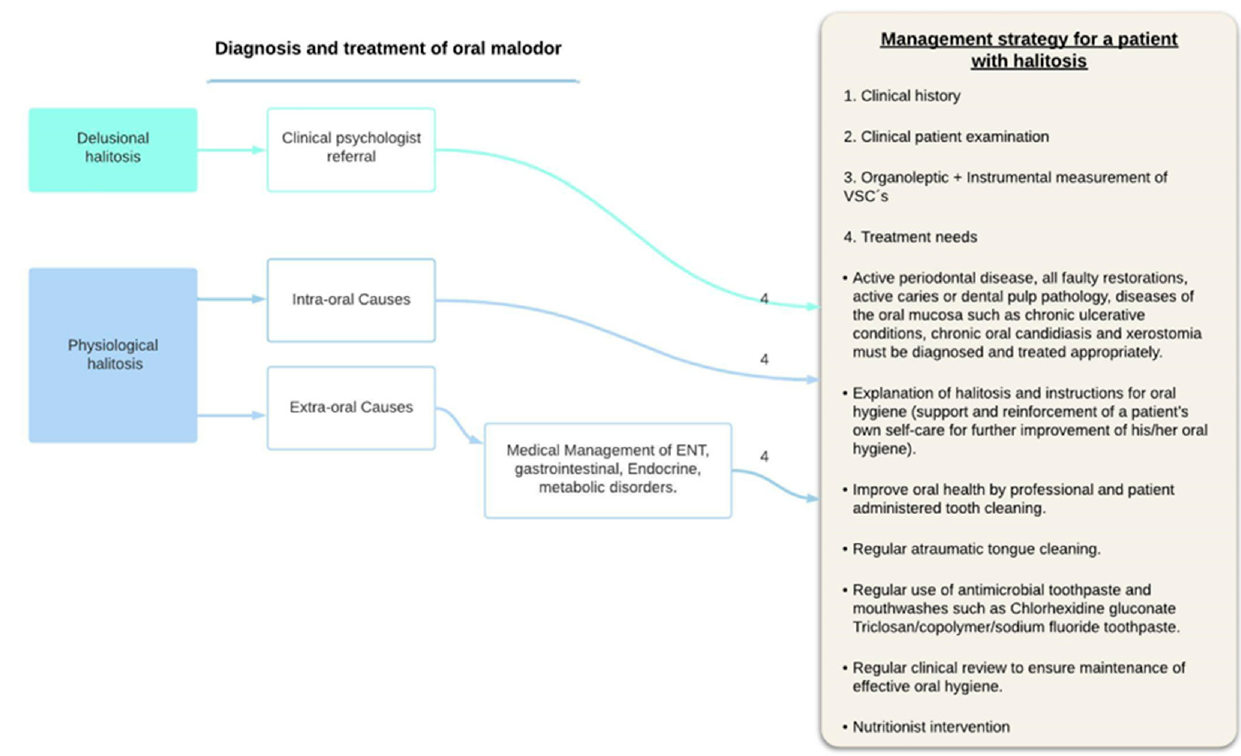
Figure 3. Treatment approach based on halitosis types and etiology.